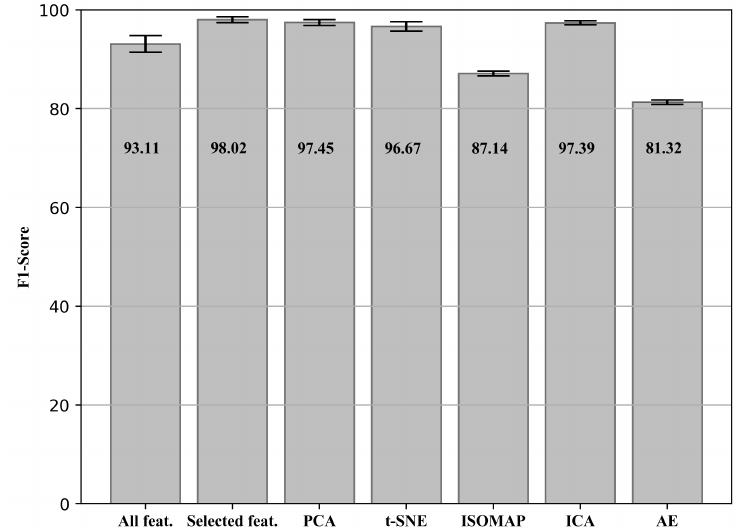
Figure 6. F1-Score and standard deviation (in percentage) obtained for the fault